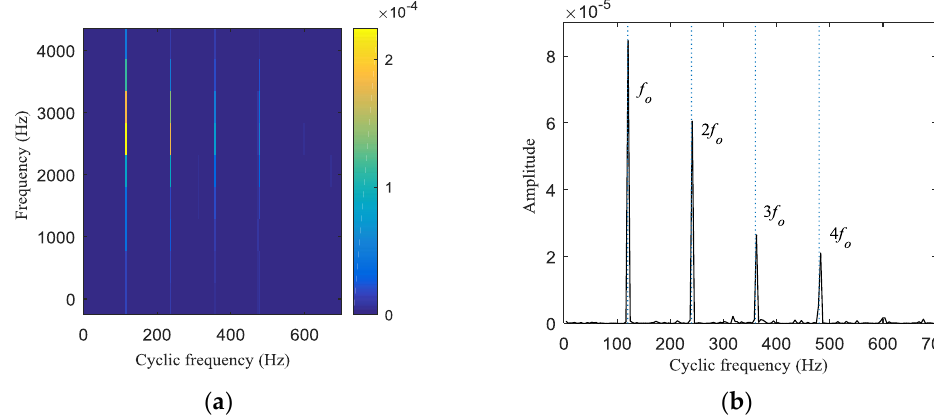
Figure 3. The processing results of x ( t ) via improved fast spectral correlation: ( a ) the improved fast spectral correlation spectrum; ( b ) the corresponding enhanced envelope spectrum.